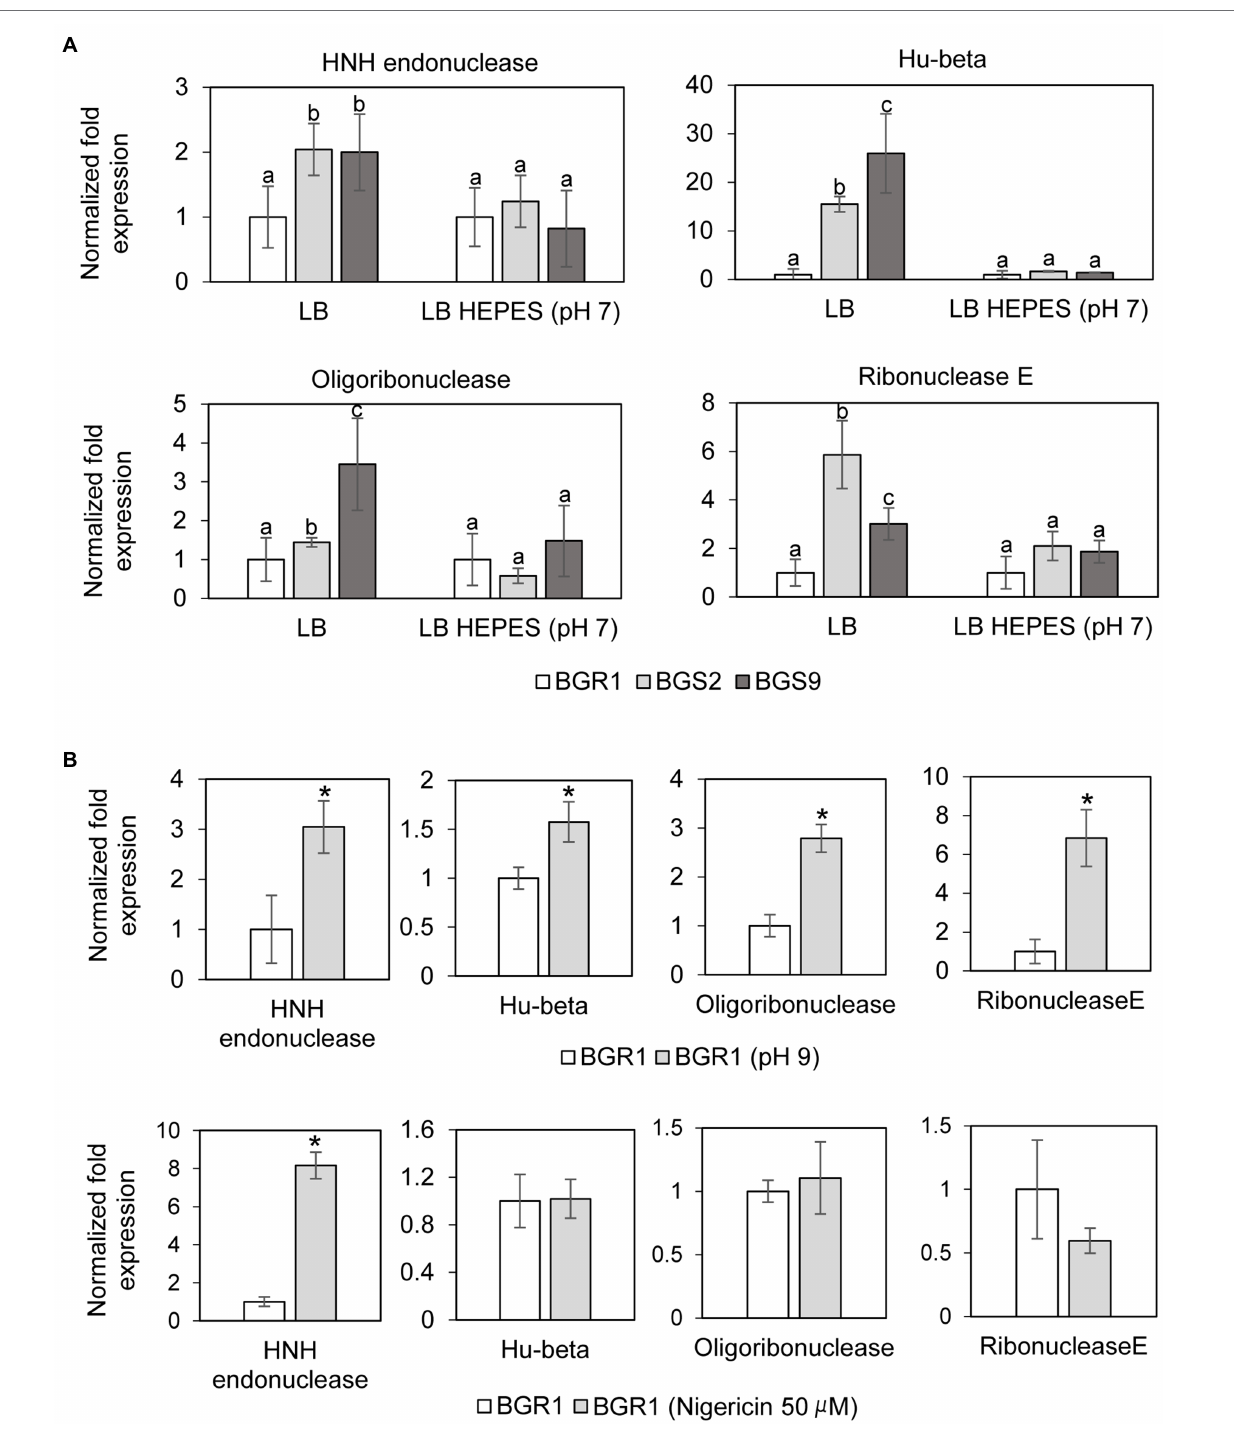
FIGURE 6 | Relative expression of genes encoding nucleotide-degrading enzymes. (A) The expression levels of genes encoding HNH endonuclease, Hu-beta, oligoribonuclease, and ribonuclease E were compared between wild-type BGR1 and QS mutants in LB broth or HEPES-buffered LB broth (pH 7) after 10 h, as revealed by quantitative reverse-transcription PCR (qRT-PCR). Data are mean ± SE of triplicate experiments. The letters (a, b, and c) above each mean represent groupings of statistical significance based on ANOVA/Tukey’s correction for multiple comparisons. A value of p < 0.05 represents significant differences among strains. (B) The relative expression of target genes in wild-type BGR1 was measured after 4 h of alkaline stress at pH 9 or at 8 h after the addition of 50 μ M nigericin. Data are mean ± SE of triplicate experiments. The asterisks (*) indicate a significant difference in expression levels ( p < 0.05) compared to the wild type as determined by ANOVA/Tukey’s correction for multiple comparisons. The 16S rRNA gene was used for normalization in all PCR